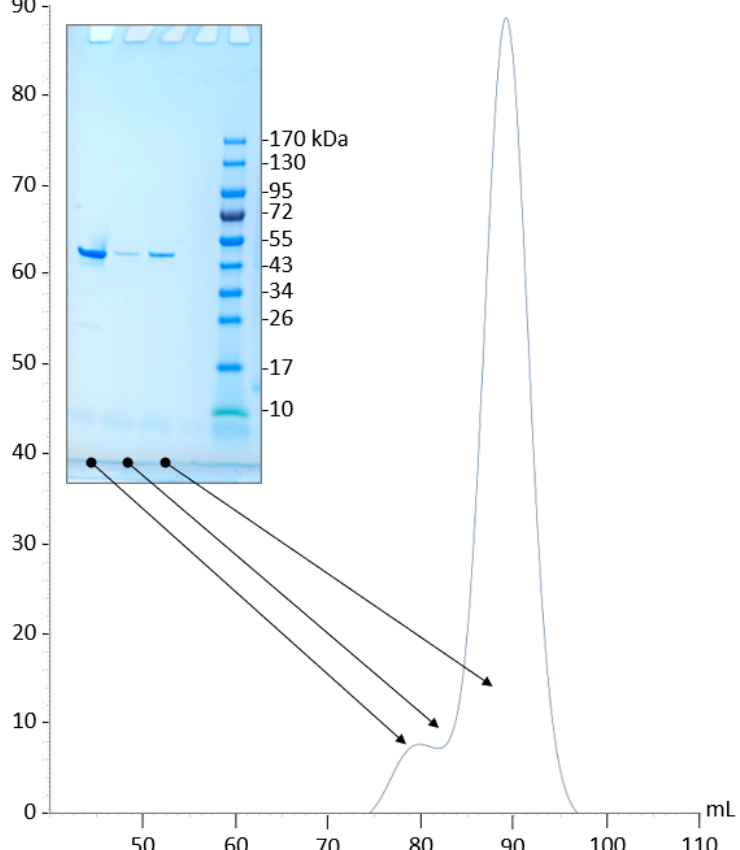
Figure 3 . SDS-PAGE gel and size exclusion chromatography purification of recombinant PyuS. For SEC, the absorbance was monitored at 280 nm. The arrows indicate the elution fraction analyzed by SDS-PAGE and the MW of PyuS is 51.3 kDa.